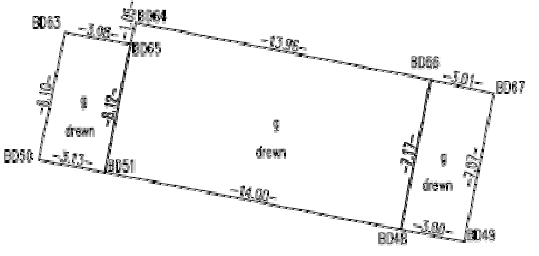
Figure 4. A fragment of a field sketch of the measurements of buildings’ corners